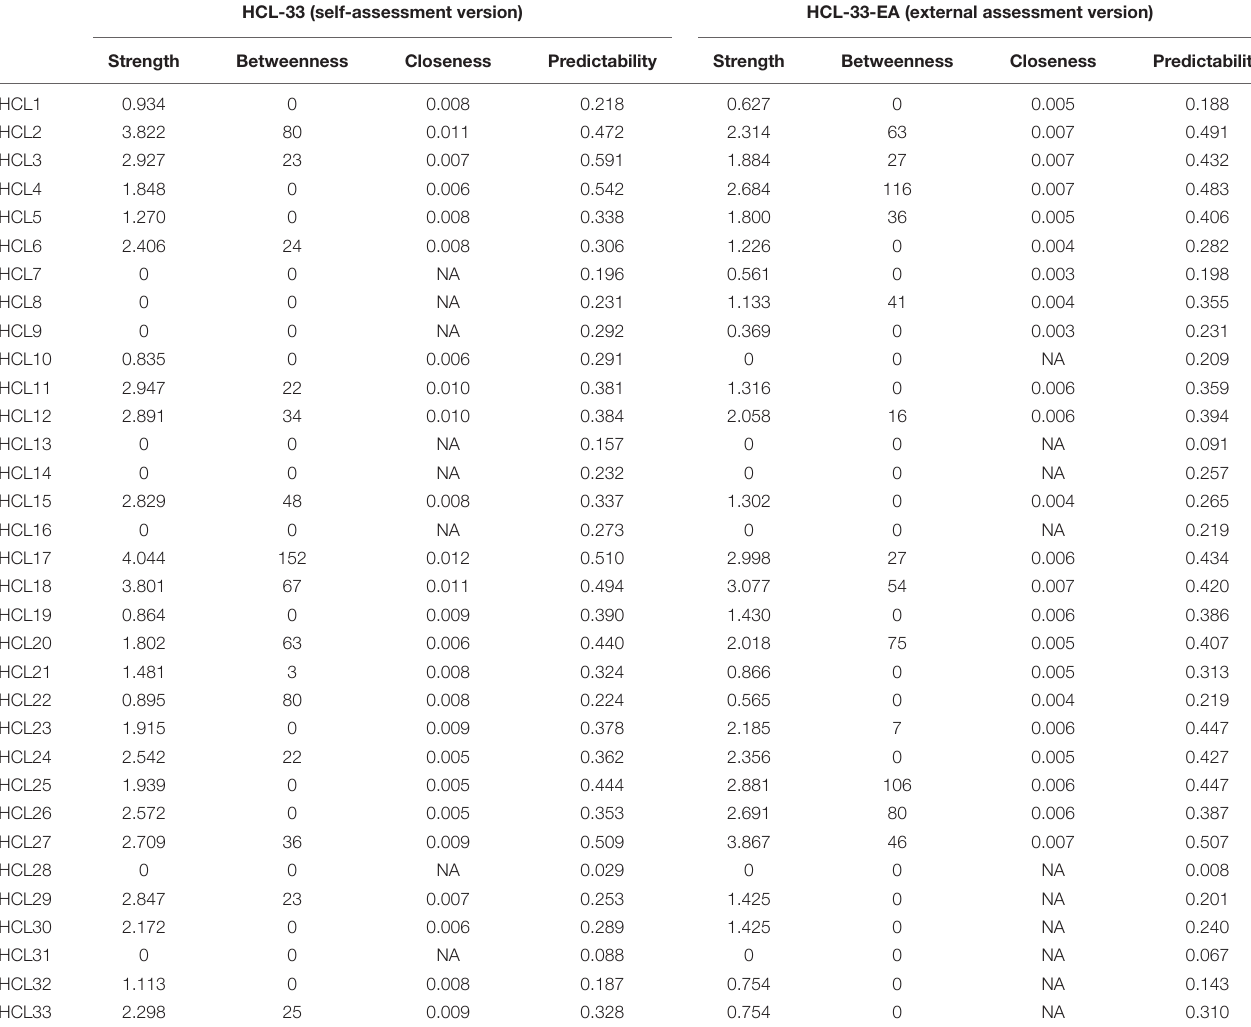
TABLE 1 | Centrality of hypomania checklist